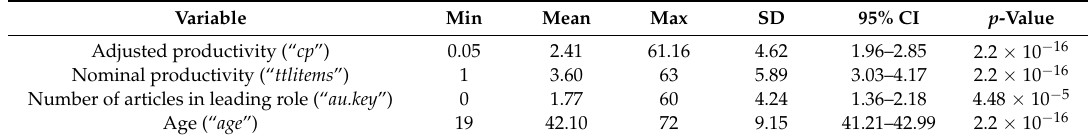
Table A1. Some descriptive statistics for the variables used in the article.